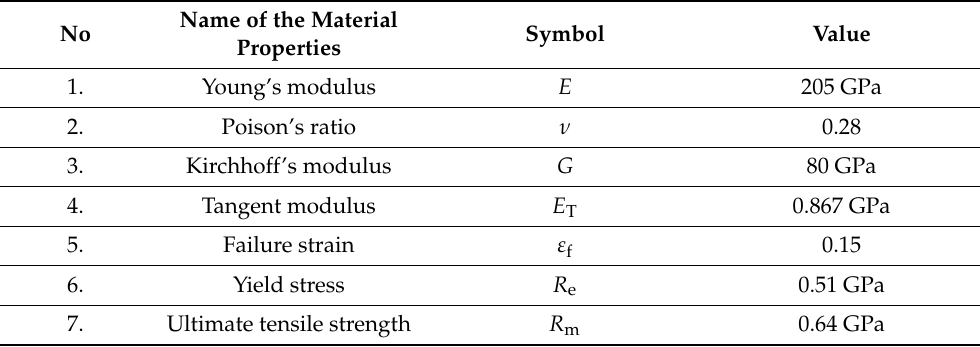
Table 1. Material properties for steel sheets being